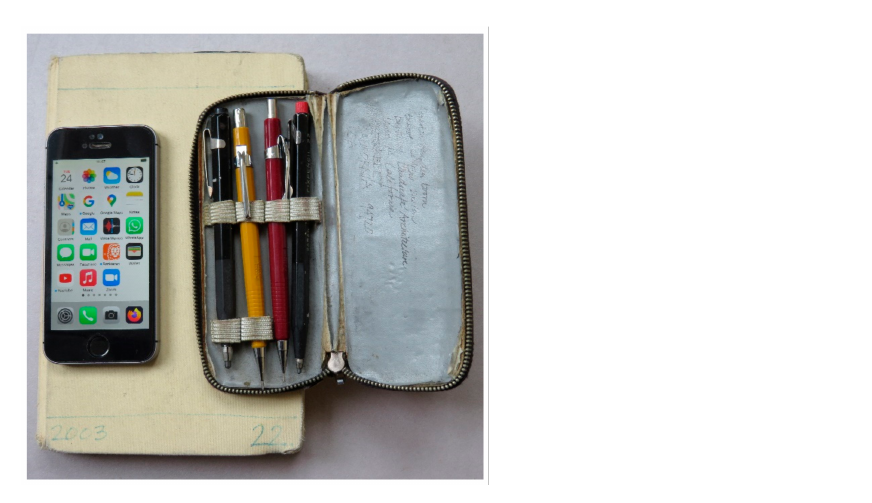
Figure 12. Contemporary tools needed for fieldwork; notebook, pencils, mobile phone. This mobile phone (iPhone SE) has, Google Earth maps for measuring distances and main contour lines, has a level and measures elevation and altitude, has a camera that can take photographs, time-lapse, panorama’s and video, has a voice recorder. It can define the location which is very handy in unknown areas, also in urban